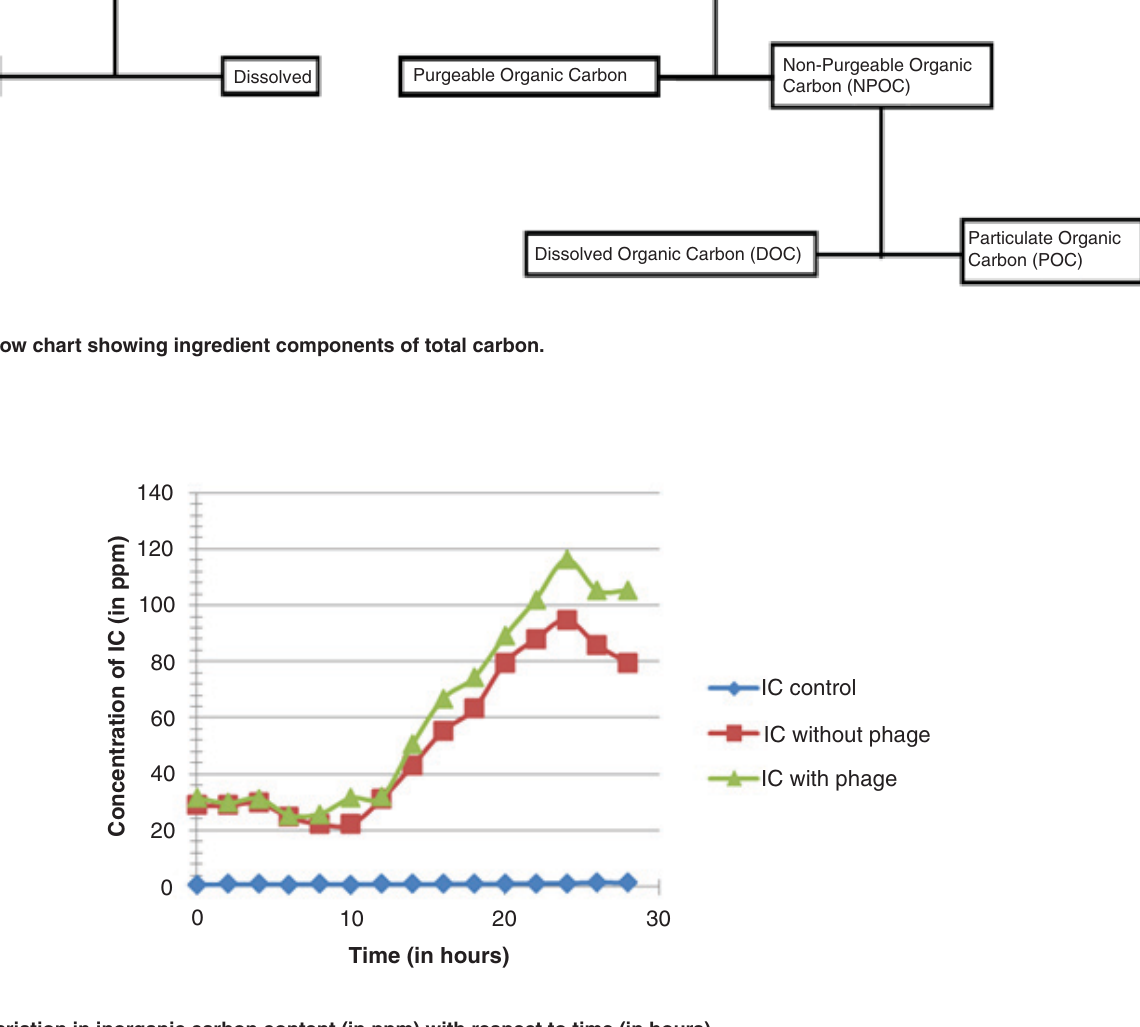
Figure 3. Variation in inorganic carbon content (in ppm) with respect to time (in